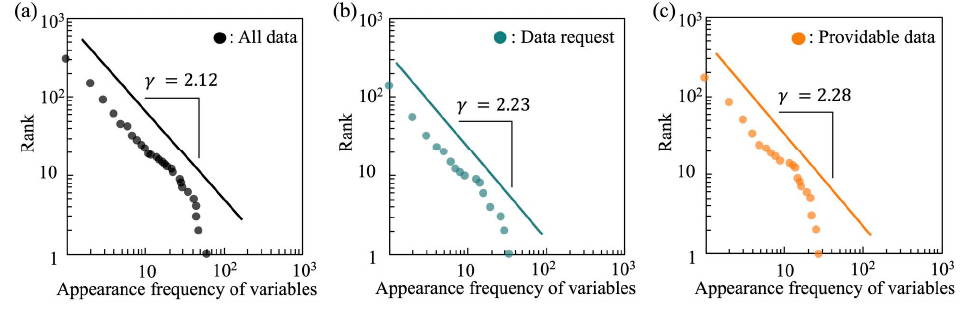
Figure 3. Distributions of the frequency of variables in ( a ) all data, ( b ) data requests, and ( c ) providable